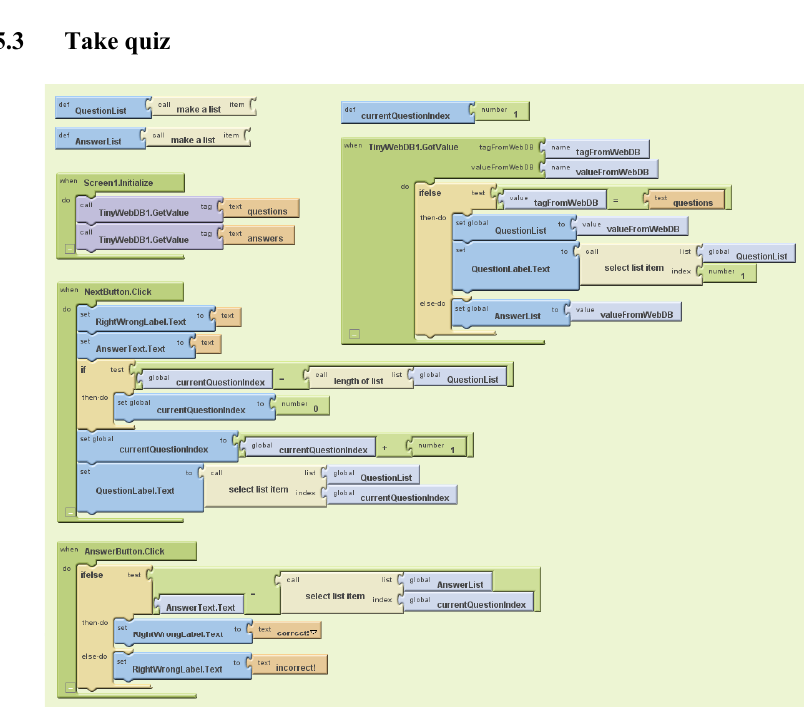
Fig. 9. Blocks screen of taking